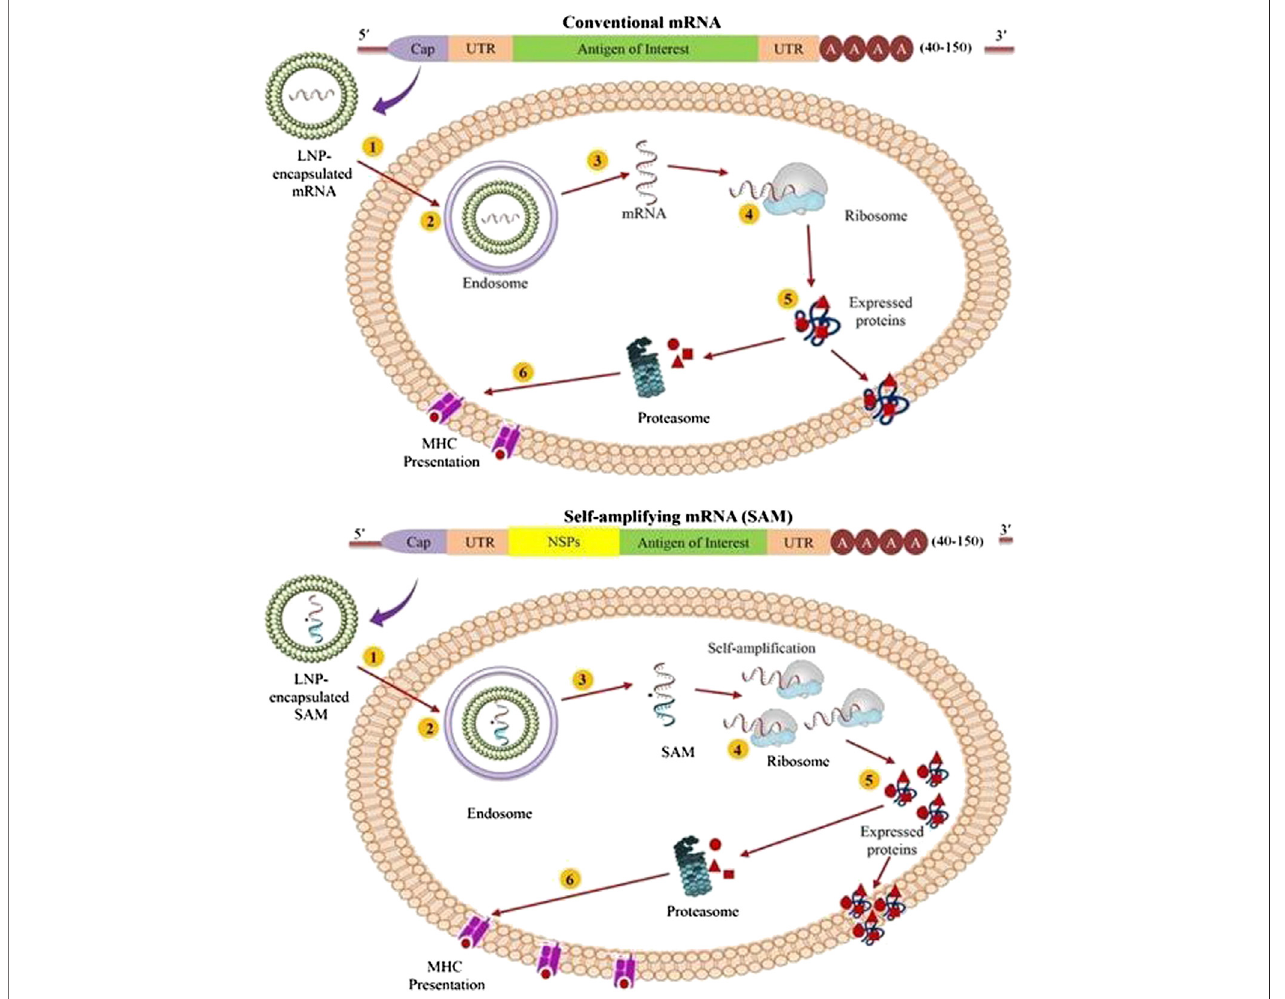
FIGURE 3 | Diagrammatic representation of mechanism of antigen expression by the conventional mRNA (Top) and self-amplifying mRNA (SAM) vaccines (Bottom) . (1) In this illustration, both conventional mRNA and SAM are shown to be formulated in lipid-derived nanoparticles (LNPs) to provide better stability; (2) The LNP formulated mRNA enters the cell through membrane-derived endocytosis processes; (3) The mRNA content shows endosomal escape to reach the cytosol; (4) In case of conventional type, the escaped mRNAs are immediately translated by the ribosomes to generate the protein of interest (Top) , while SAM constructs undergoestranslationtoproducethereplicasecomplextoexhibitself-ampli fi cationoftheencodedmRNA,followedbytranslationoftheantigenofinteresttoexpressthe desiredprotein (Bottom) ;(5)Thentheexpressedproteinsundergoessubsequentpost-translationalmodi fi cationtoappearastrans-membrane,intracellularorsecreted protein;and(6)Theexpressedproteinsarethenbrokendowntopeptidesbytheproteasome,andthepeptideformedarepresentedtotheimmunesystembythemajor histocompatibility complex (MHC).